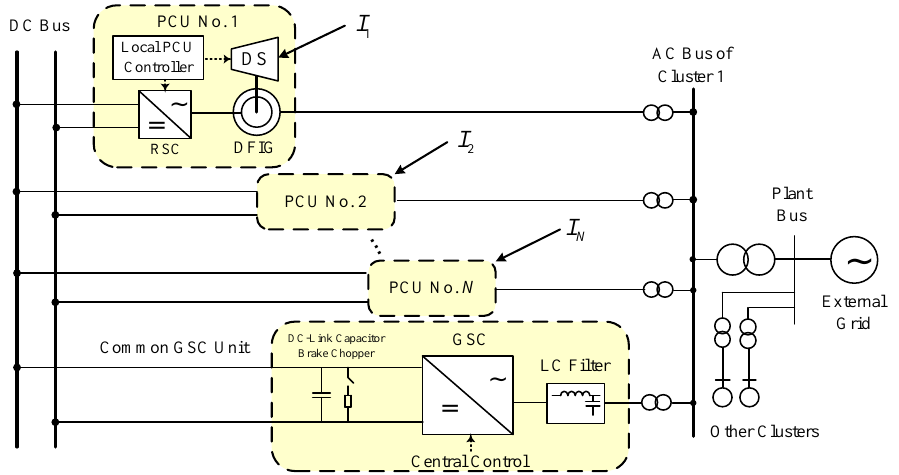
Figure 2. Proposed configuration of a DFIG-based DS solar-thermal power plant using a common dc bus and a common GSC unit.